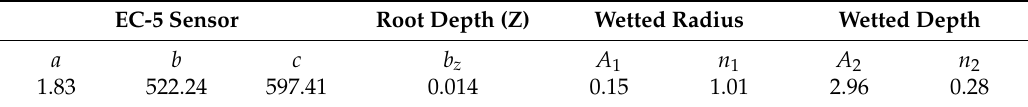
Table 1. The parameters of the EC-5 sensor, root depth model and wetting pattern model.